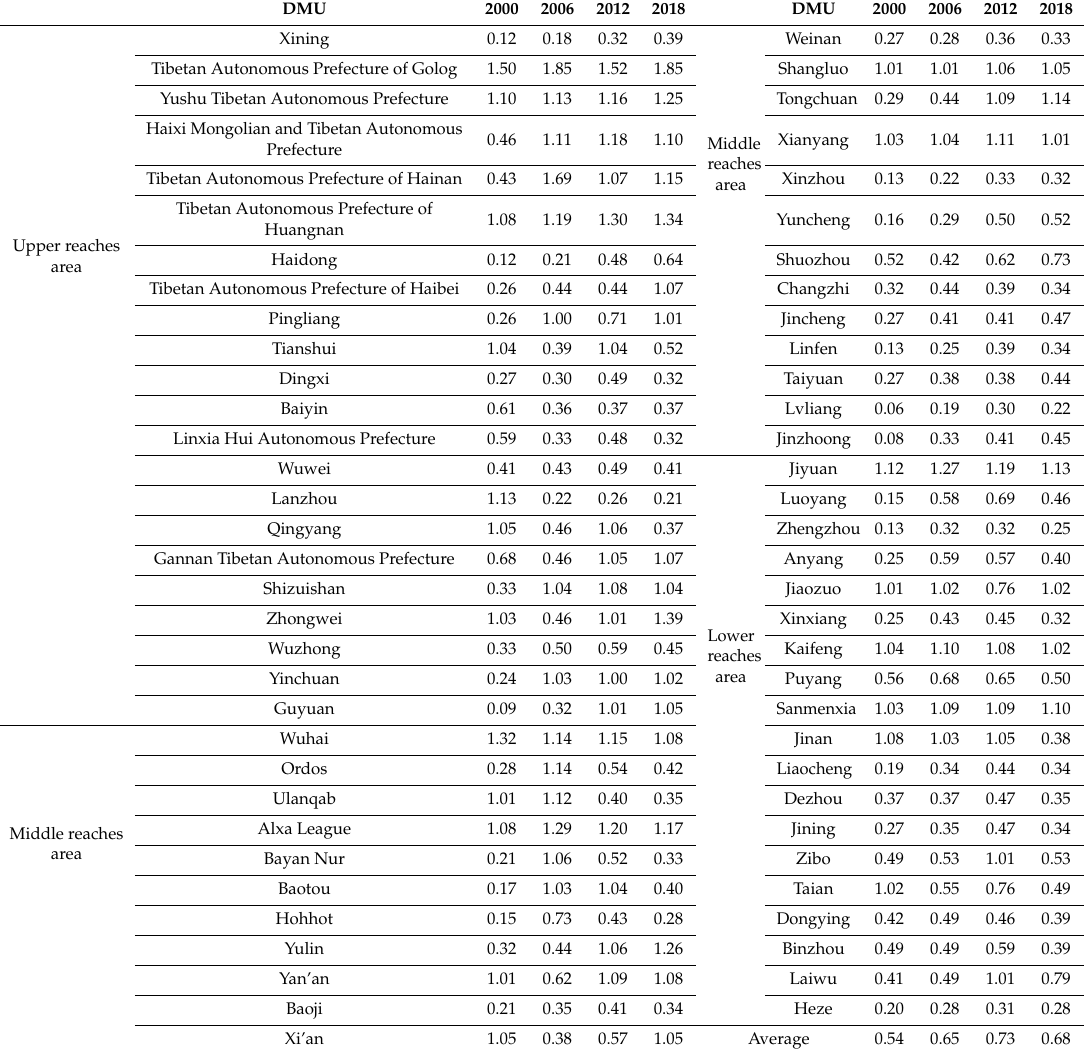
Table 2. GUECL in 65 cities (regions, autonomous prefectures) in the Yellow River